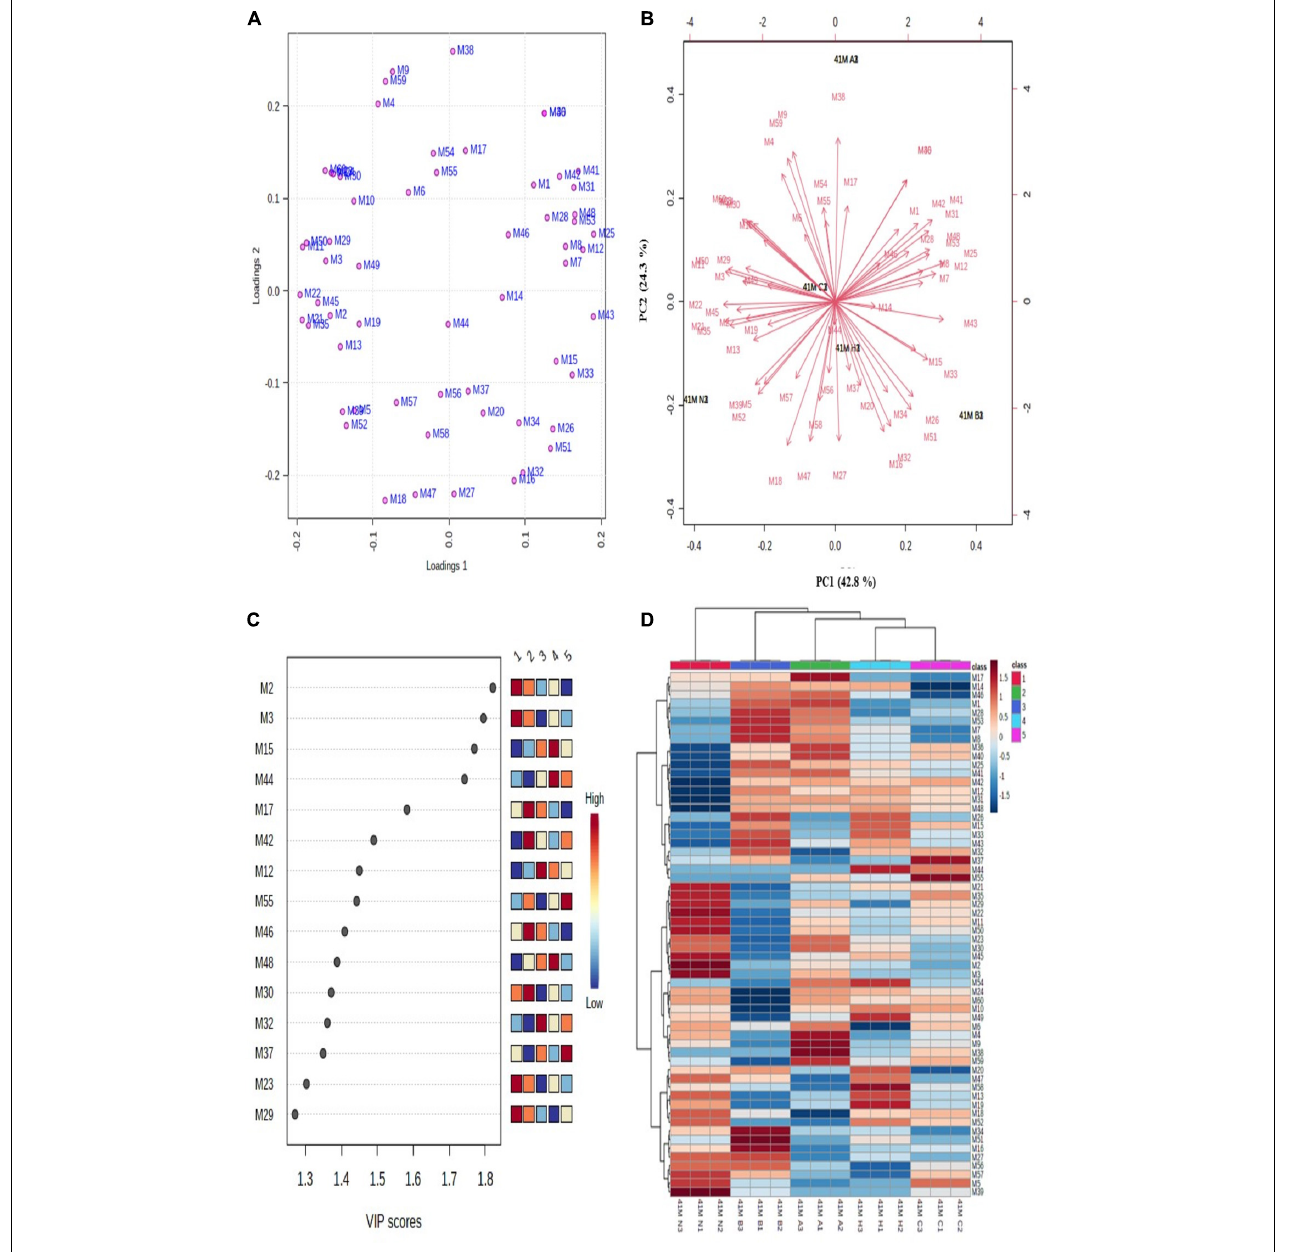
FIGURE 4 | Multivariate data analysis using MetaboAnalyst software. (A) PCA loading plot; (B) PCA biplot for variations among differentially expressed proteins, (C) VIP score plot for proteins with maximum abundance, and (D) hierarchical clustering and correlation heatmap. Each colored cell in heatmap represents average peak intensity value in Table 1 . The column represents stress treatments and rows represents proteins (41 N = control, 41 A = acid, 41 B = bile, 41 C = cold, and 41 H = heat). The color red indicates increased and blue indicates decreased Z scores which represent standard deviation from the mean as compared to the